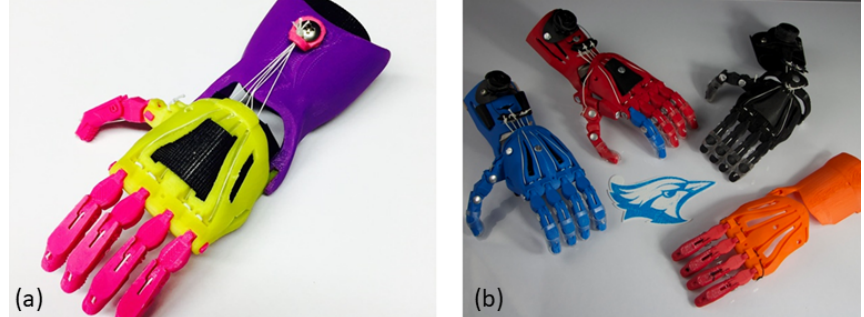
Figure 3. The Cyborg Beast by Creighton University’s Jorge M. Zuniga and available on Thingiverse https://www.thingiverse.com/thing:261462. ( a ) Personalized assembled device. ( b ) A group of assembled hands featuring different cosmetic